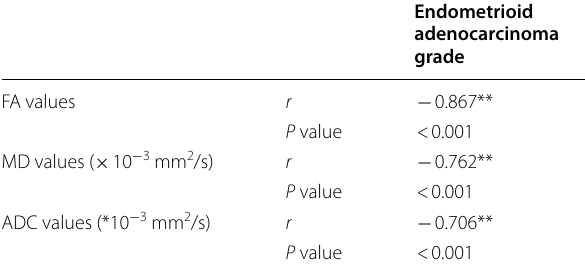
Table 7 Correlation between DT‑FA, MD and DW‑ADC and endometrioid adenocarcinoma grades